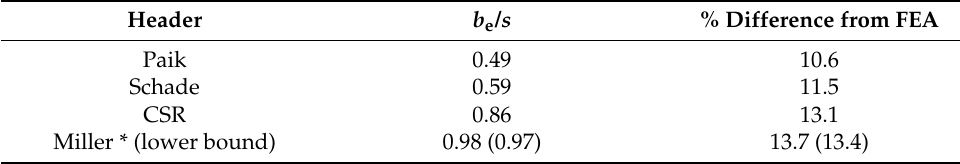
Table 3. Assessment of the effective width solution with respect to the FEA maximum normal stress for the panel taken from the topside wing tank area of the ship. In Miller’s solution the out of parenthesis corresponds at the uniaxial E * and within parenthesis at the biaxial E *. Header b e / s % Difference from FEA